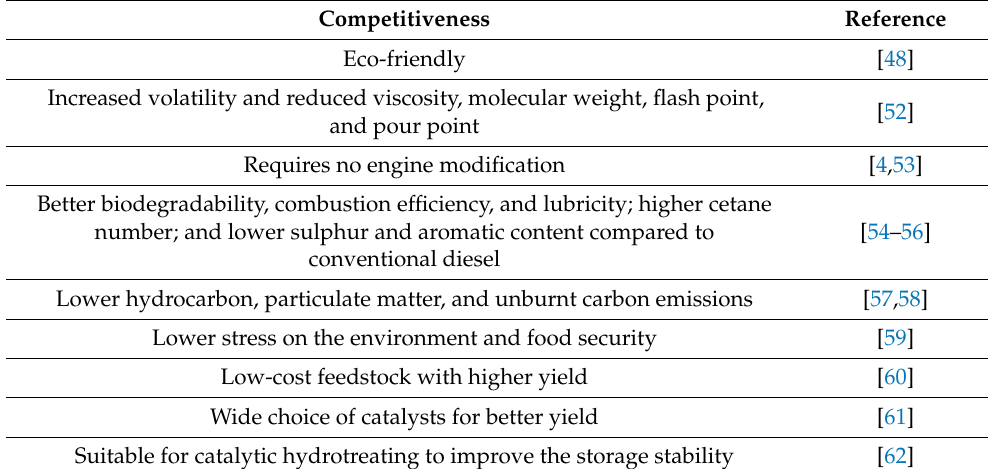
Table 2. Competitiveness of transesterification process for WCO biodiesel